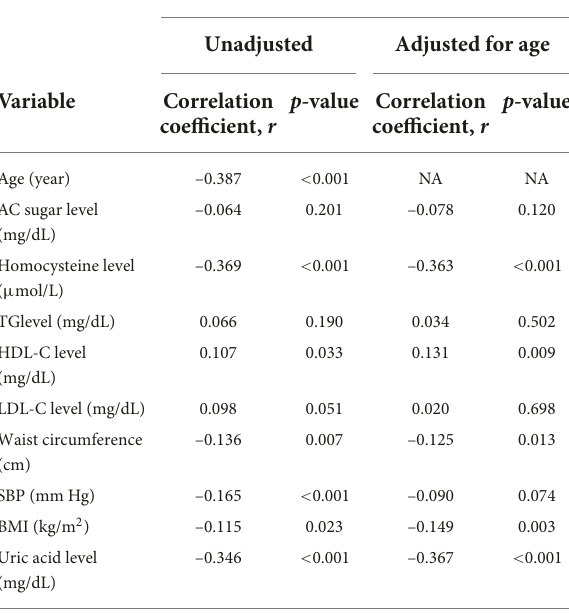
TABLE 2 The correlation between eGFR and metabolic risk factors. eGFR (mL/min/1.73 m 2 ) Unadjusted Adjusted for